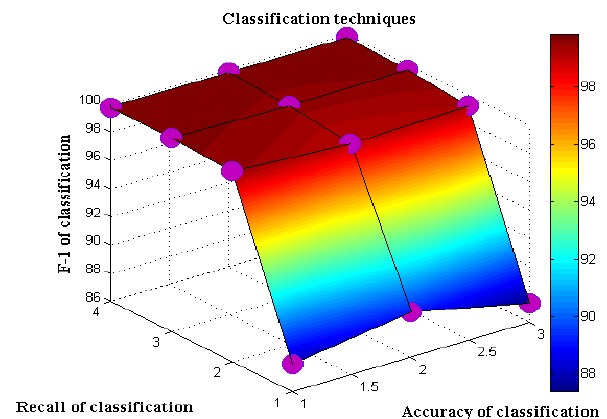
Figure 14. Detection rate.